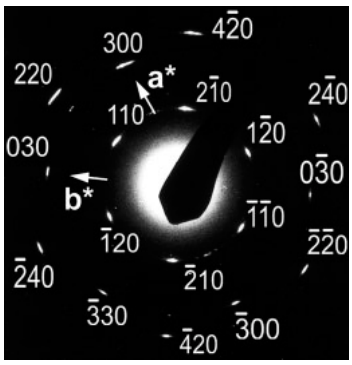
Figure 5. Electron diffraction pattern of an iPBu single flat-on crystal in the trigonal form. The sample was prepared by melting the solution-grown trigonal crystals at 136 °C for 2 min and then crystallized isothermally at 75 °C. Reproduced with permission from Ref. [46], copyright 2007 Wiley Periodicals, Inc.